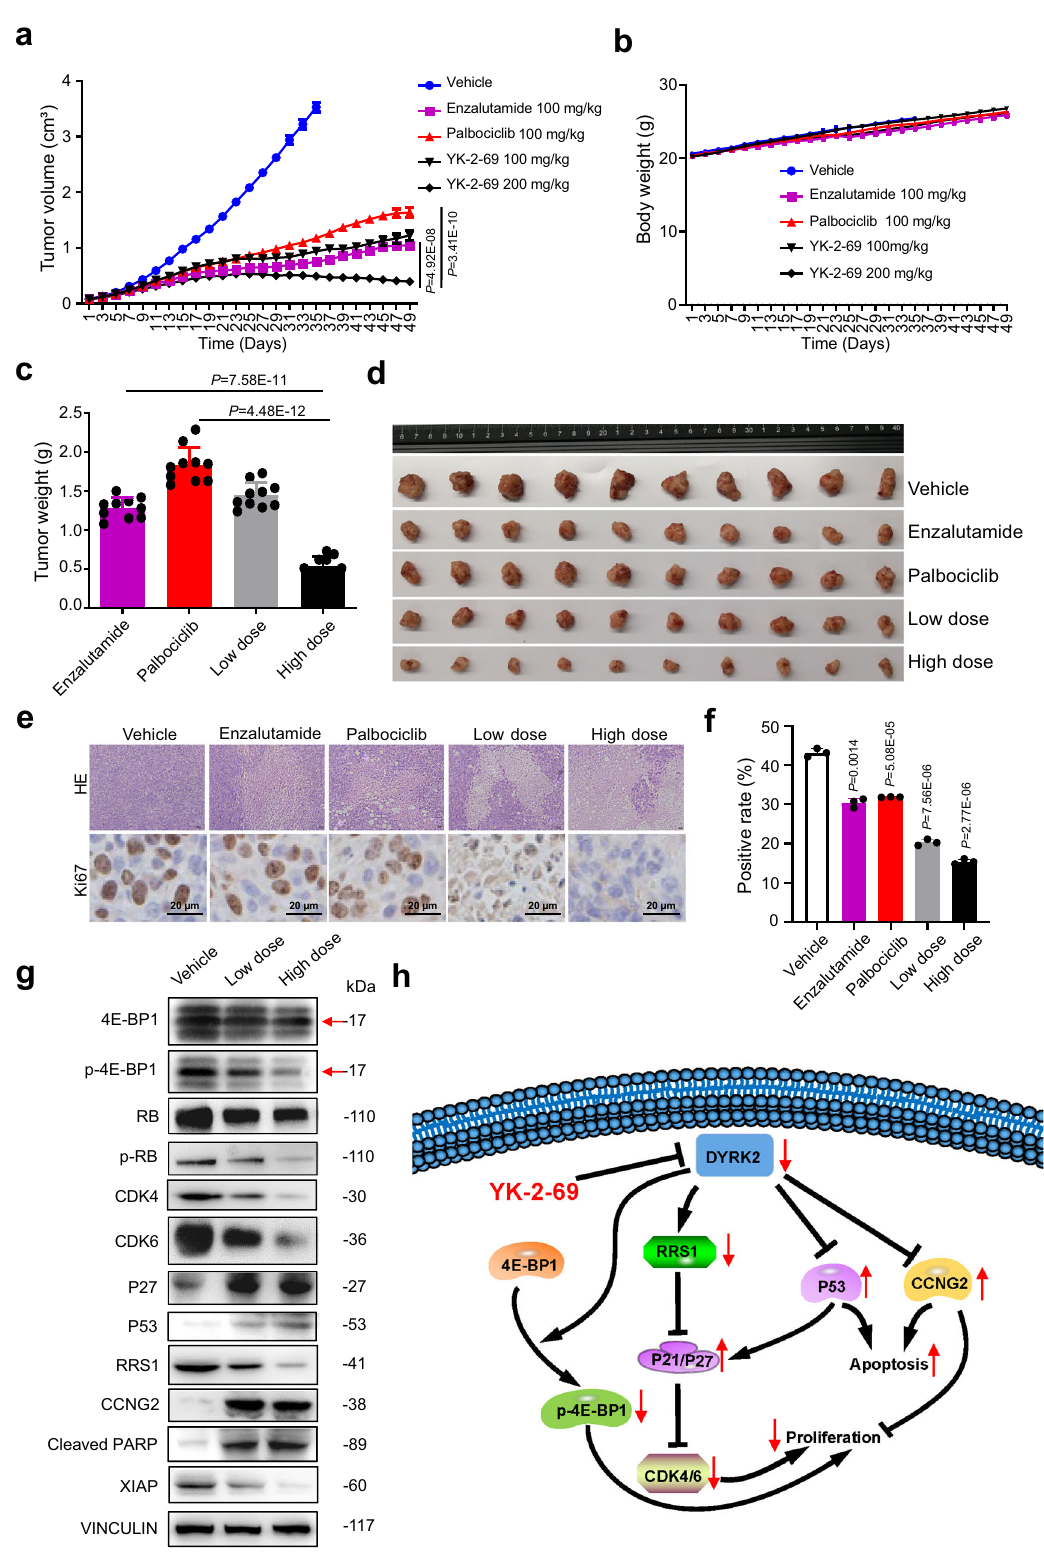
CDK4/6, RRS1, and XIAP were deregulated, and P27, P53, CCNG2, and cleaved PARP were upregulated (Fig. 7g). Mean- while, YK-2-69 also signi fi cantly inhibited tumor growth in the PC-3 xenograft mouse model. Furthermore, same as YK-2-69 reducing tumor size in the DU145 xenograft model, the high dose of YK-2-69 could also decrease tumor volume in the